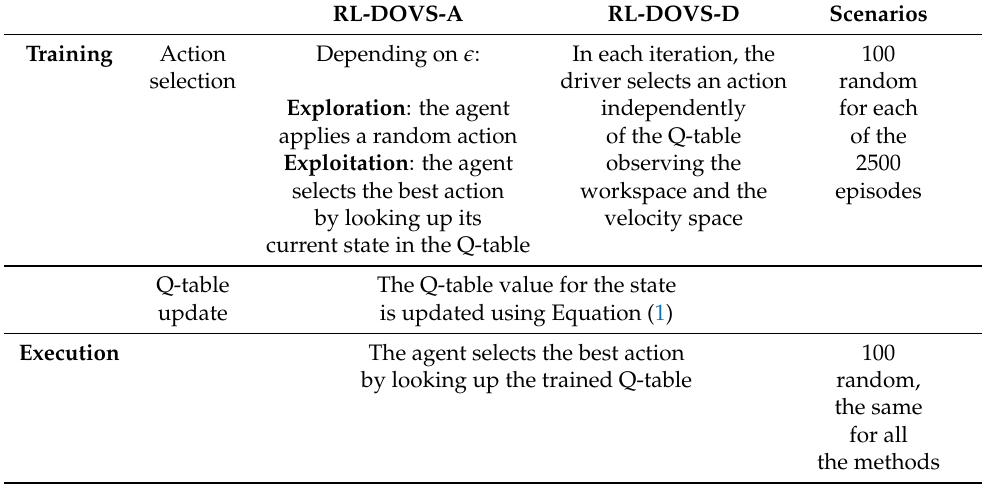
Table 3. Differences between RL-DOVS-A and RL-DOVS-D.